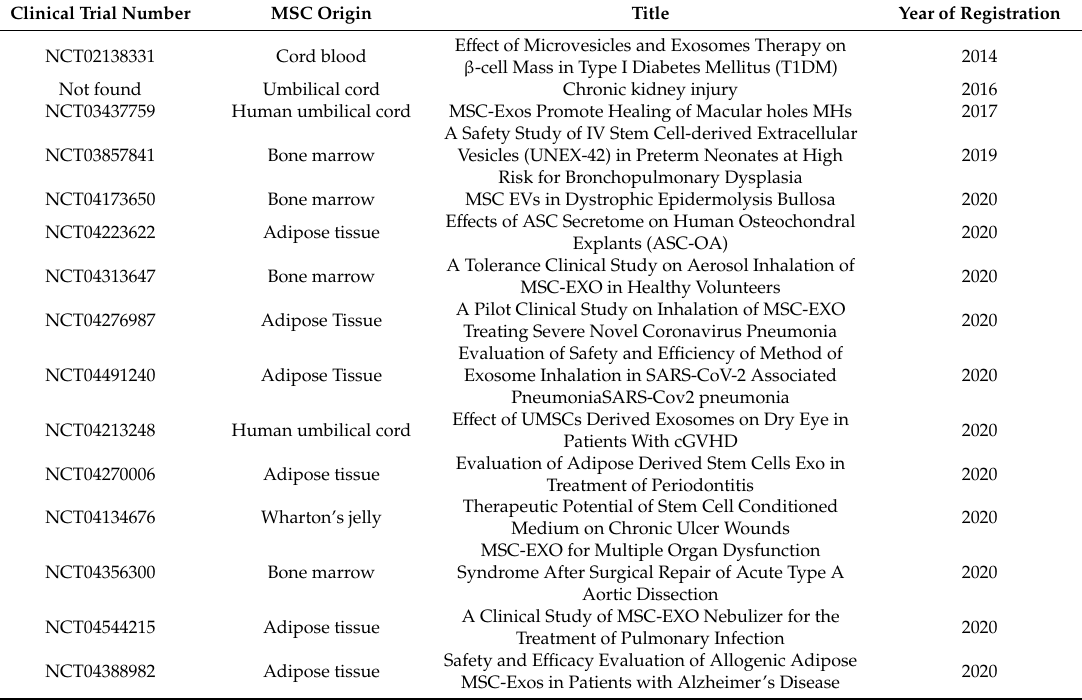
Table 1. List of registered clinical trials from 2014 to